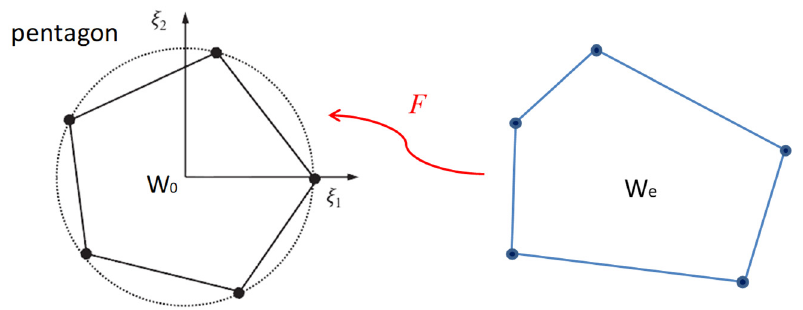
Figure 6. Illustration of mean-value coordinates.